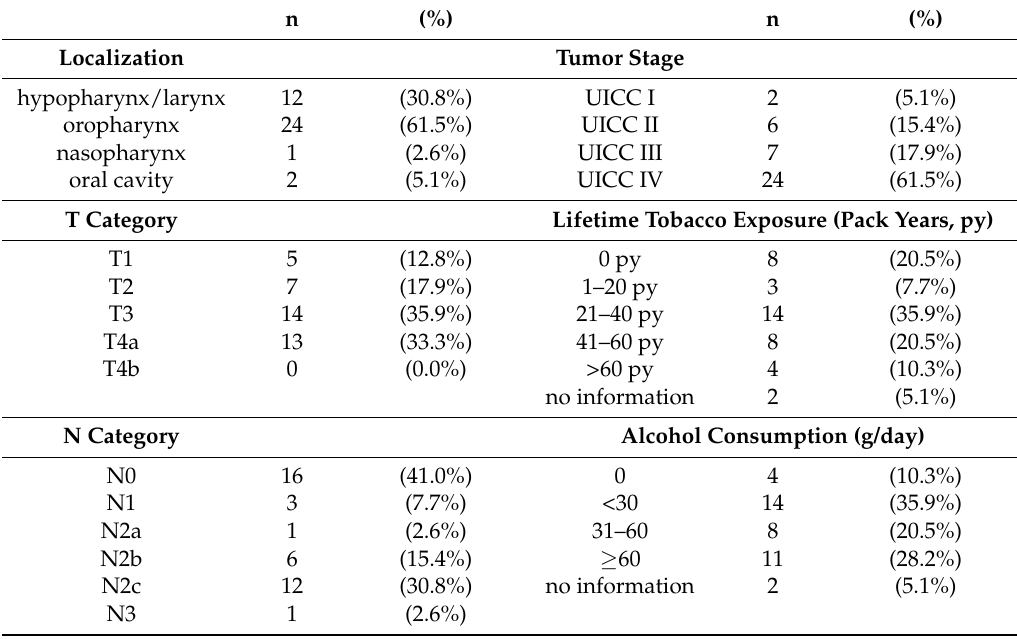
Table 1. Characteristics of 39 histopathologically confirmed head and neck squamous cell carcinoma (HNSCC) of 34 male and 5 female patients (mean age at 60.3